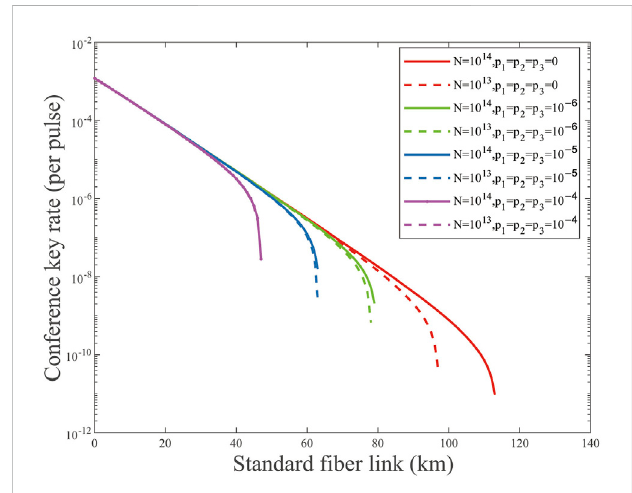
FIGURE 4 (Color online) Conference key rate (per pulse) on a logarithmic scale vs. transmission distance for p 1,2,3 = 0, 10 − x ( x = 6, 5, 4) and different values of N = 10 14 , 10 13 . The solid lines are the results of N = 10 14 , and the dashed lines are the results of N = 10 13 .